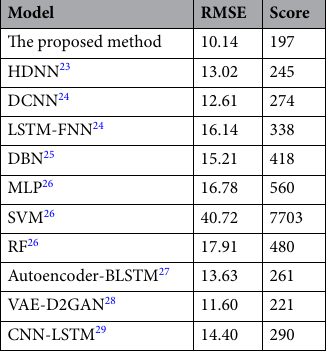
Table 5. results of various mainstream RUL prediction